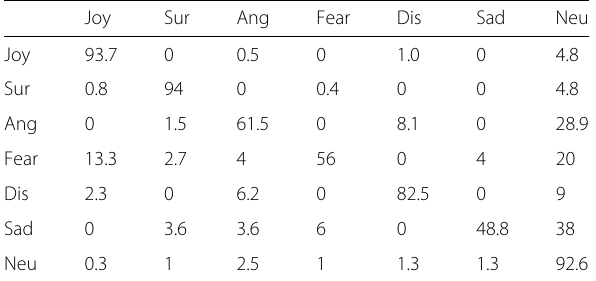
Table 8 Confusion matrix (%) of person independent testing method for 7-class emotion in CK+ dataset using Improved GLTP